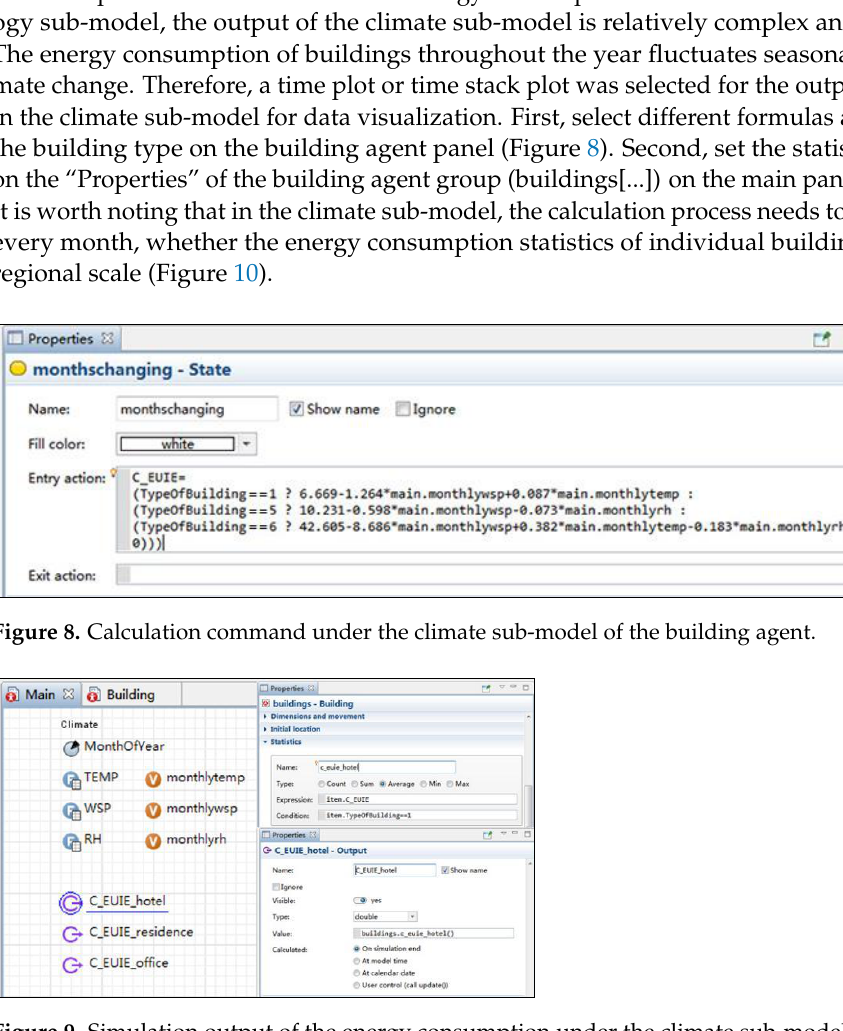
Figure 10. Update settings of climate sub-model data. 2.4. Model Validation In traditional models, independent and dependent variables are associated. How- ever, agent-based models include multiple independent variables and attributes to ex- press the element’s heterogeneity, w hich makes it difficult to be tested simply by data [69]. The validation of an agent-based model should depend on the model structure.